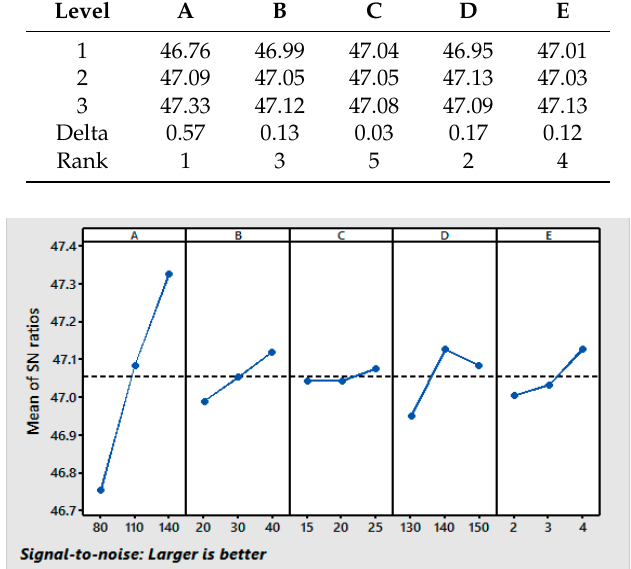
Figure 1. Main effect plots for S/N ratios [Response: CRA].